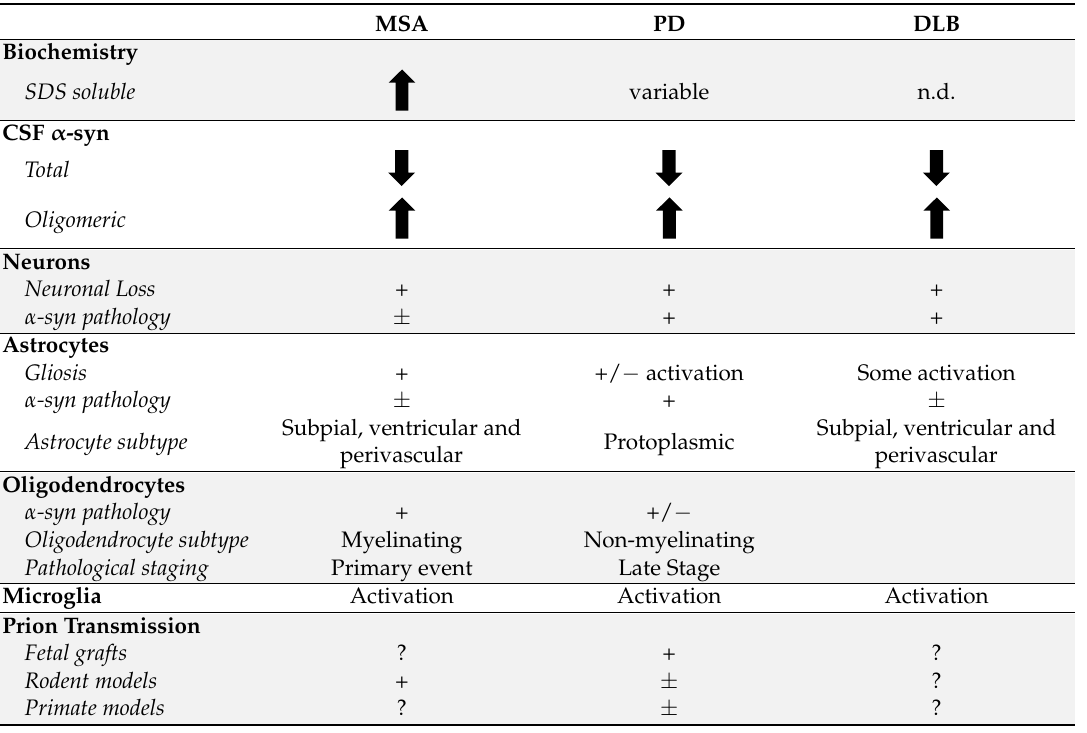
Table 1. Pathological distinctions between α-synucleinopathies. MSA may be distinct from PD and DLB due to the greater role of extracellular α-syn. There is increased sodium dodecyl sulfate soluble α-syn in MSA brain tissue [165], reduced retention of α-syn in neurons and uptake of α-syn by oligodendrocytes, astrocytes, and microglia.